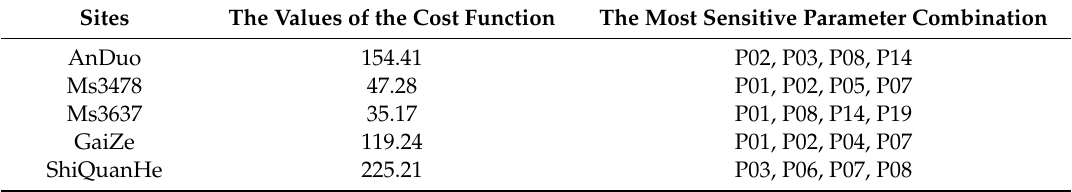
Table 4. The most sensitive parameter combinations for LH at different sites and their corresponding values of the cost function.